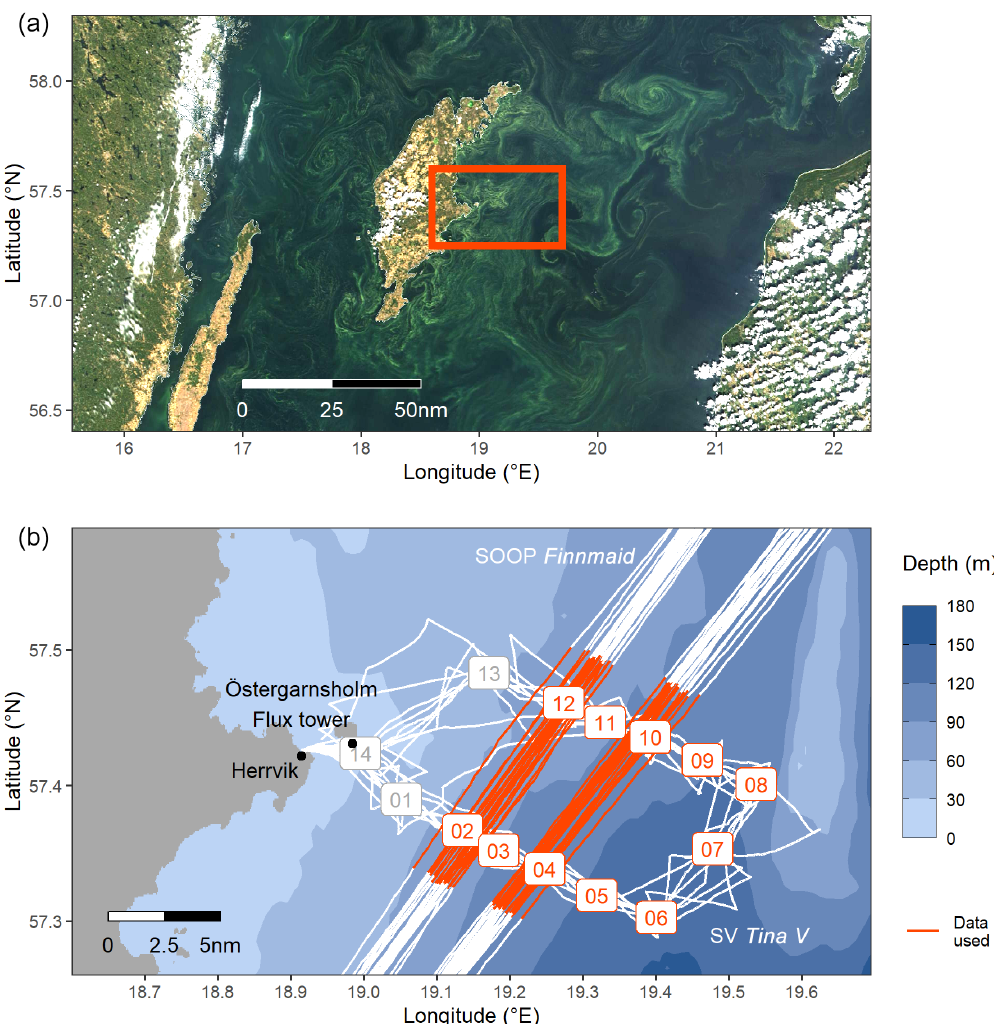
Figure 1. (a) Extent of the cyanobacteria bloom on 26 July, detectable as greenish patterns in a true-colour satellite image (MODIS Aqua– Terra, NASA Worldview) showing the Central Baltic Sea around the island of Gotland. The box indicates the study area as shown in (b) , a bathymetric map with the cruise tracks of SV Tina V (BloomSail campaign) and SOOP Finnmaid . BloomSail stations and the SOOP sub-transects used in this study are highlighted in red. The ICOS flux tower for atmospheric measurements is located on the island of